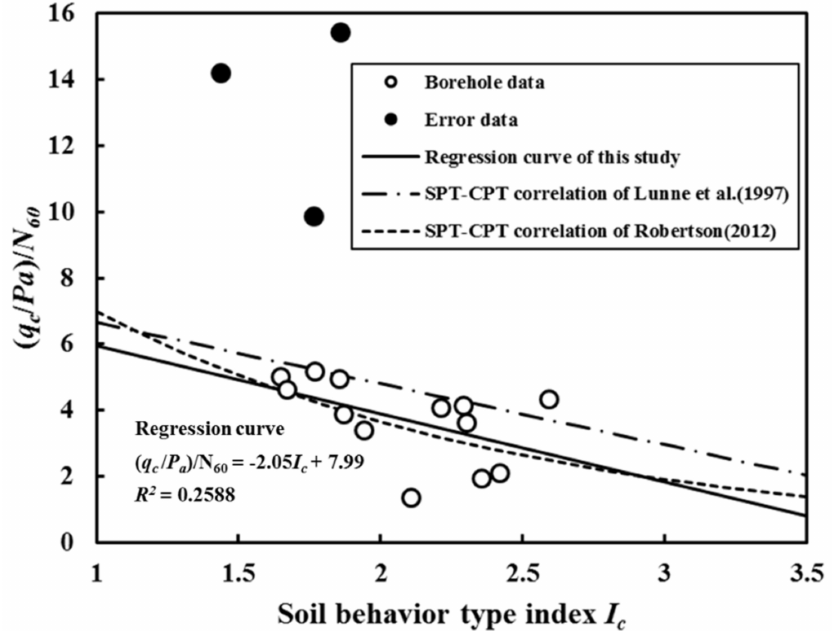
Figure 7. Relationship between SPT- N 60 and CPT- q c as a function of I